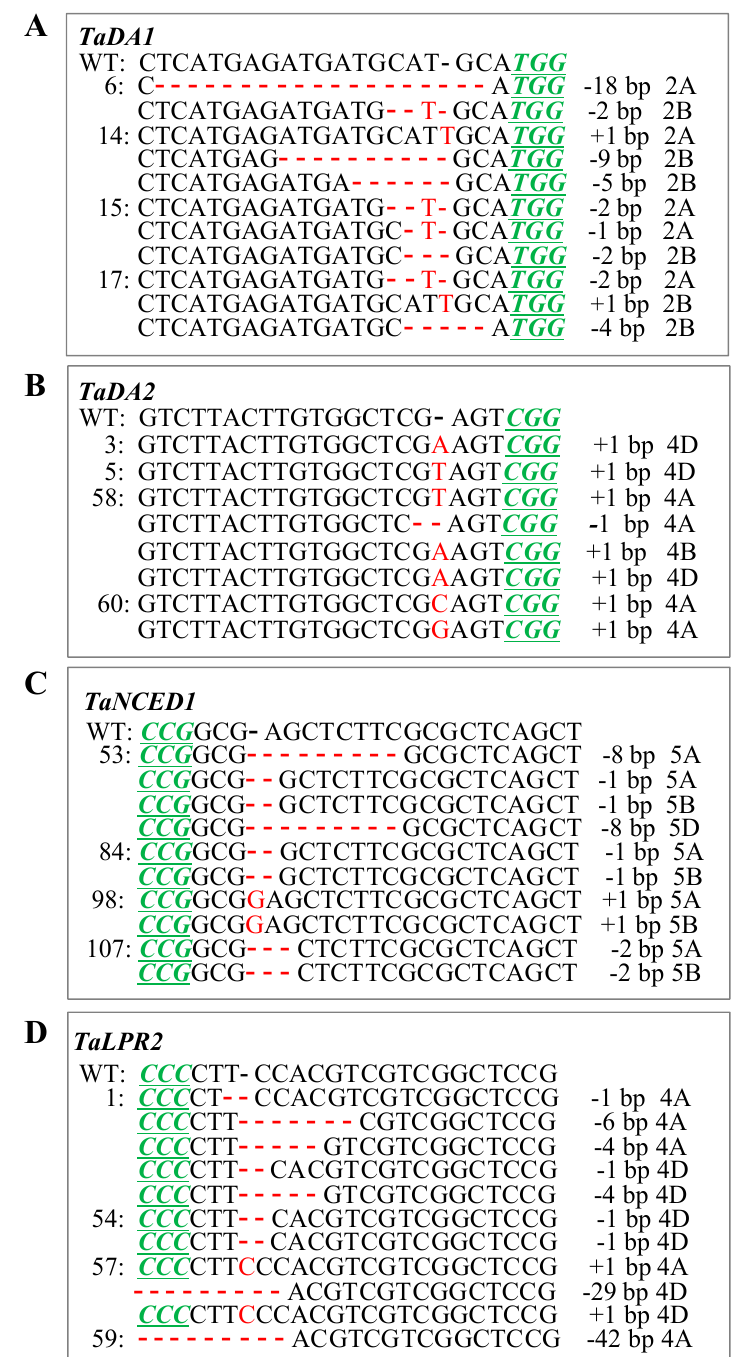
Figure 2. CRISPR / Cas9-induced targeted mutagenesis of the target genes TaDA1 ( A ), TaDA2 ( B ), TaNCED1 ( C ) and TaLPR2 ( D ) in the T0 plants. The mutation sites are indicated in red. The PAM (NGG) sites are underlined and indicated in italics in green.